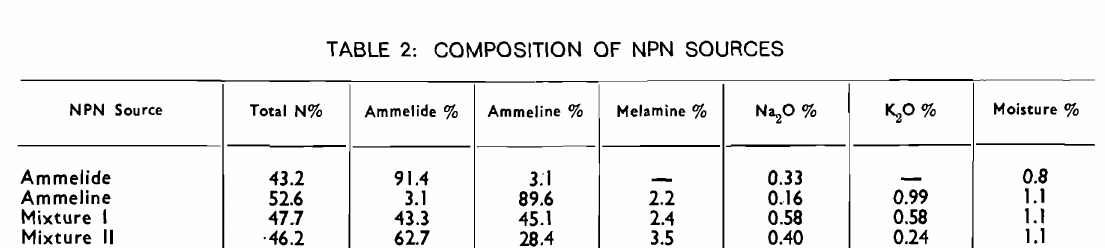
TABLE 2: COMPOSITION OF NPN SOURCES